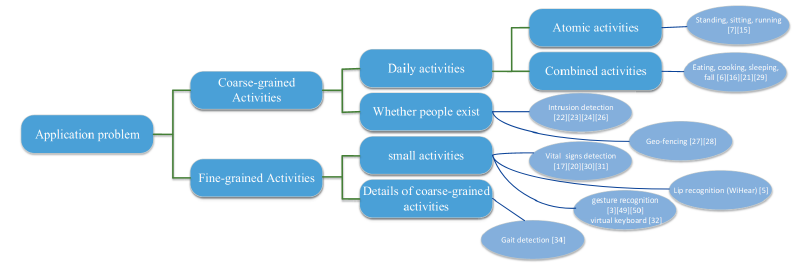
Figure 7. Human-related activity classification by Ma et al.